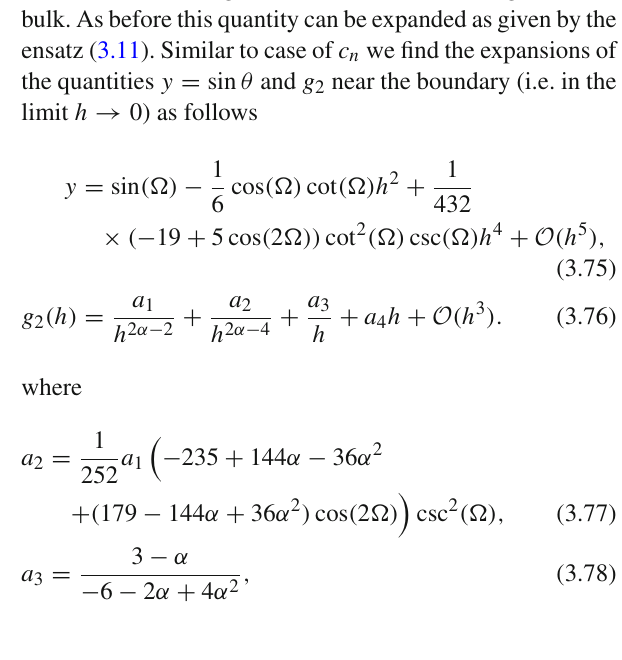
Table 2 Entanglement entropy for k × R l d Geometry Natural Geometrical singularities α New divergences for